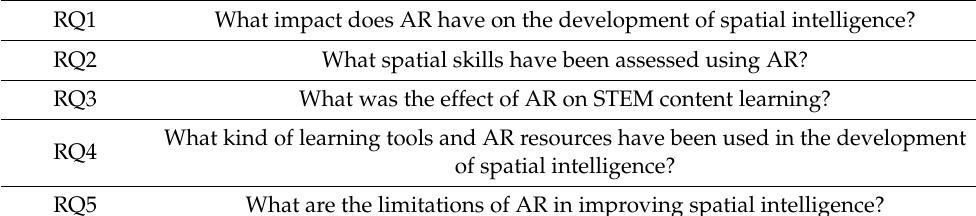
Table 1. RQs related to the application of AR in STEM education and their impact on students’ spatial intelligence. RQ1 What impact does AR have on the development of spatial intelligence? RQ2 What spatial skills have been assessed using AR? RQ3 What was the effect of AR on STEM content learning? What kind of learning tools and AR resources have been used in the development RQ4 of spatial intelligence? RQ5 What are the limitations of AR in improving spatial